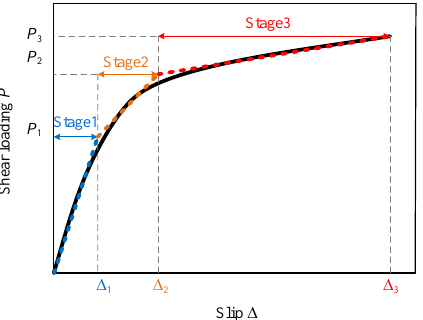
Figure 1. The typical load–slip curve and its approximation with triple segments.